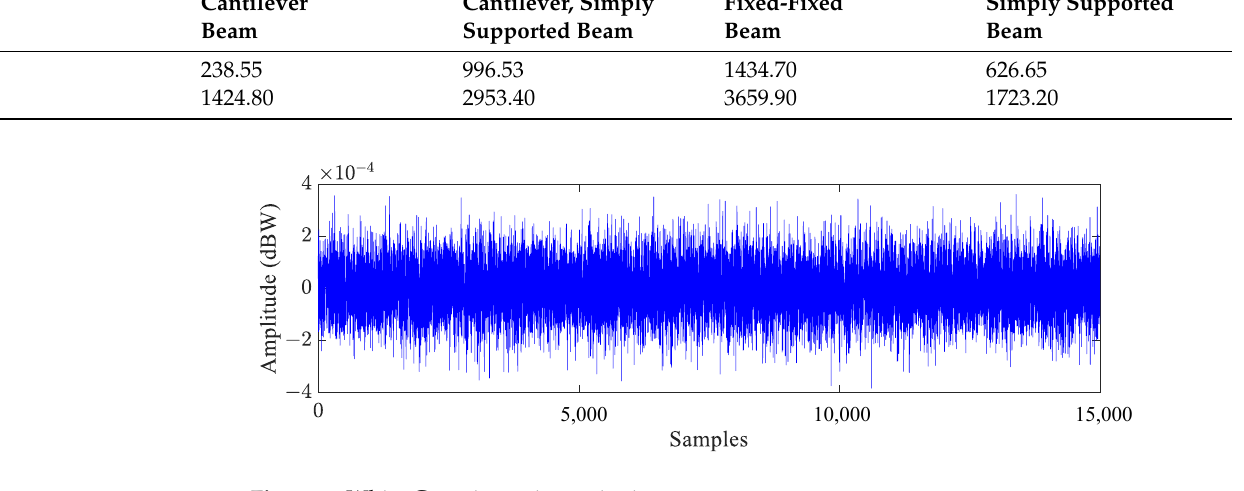
Figure 5. White Gaussian noise